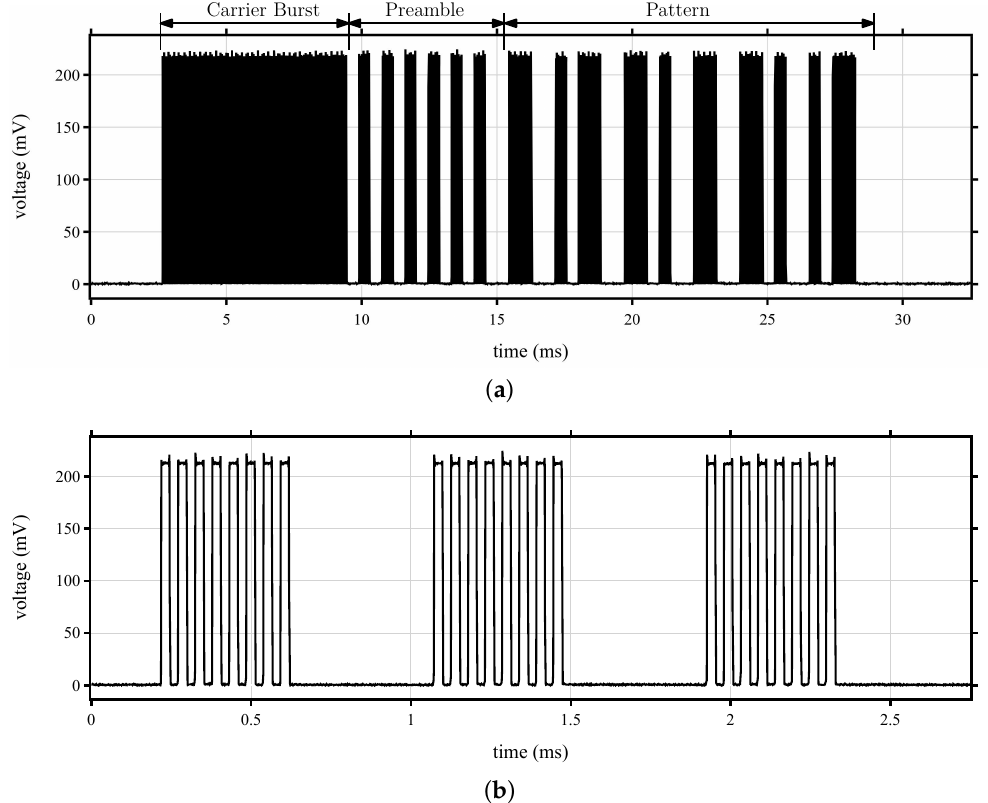
Figure 13. Manchester coded wake-up packet. ( a ) Pattern with carrier burst, preamble, and address; ( b ) OOK signal on kilohertz